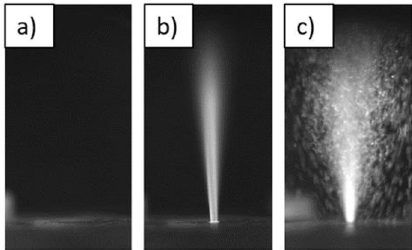
Fig. 4. Comparison between the aggregate states gaseous (a), solid (b) and liquid (c) during the fl ow out of CO 2 through a laser- drilled microhole.